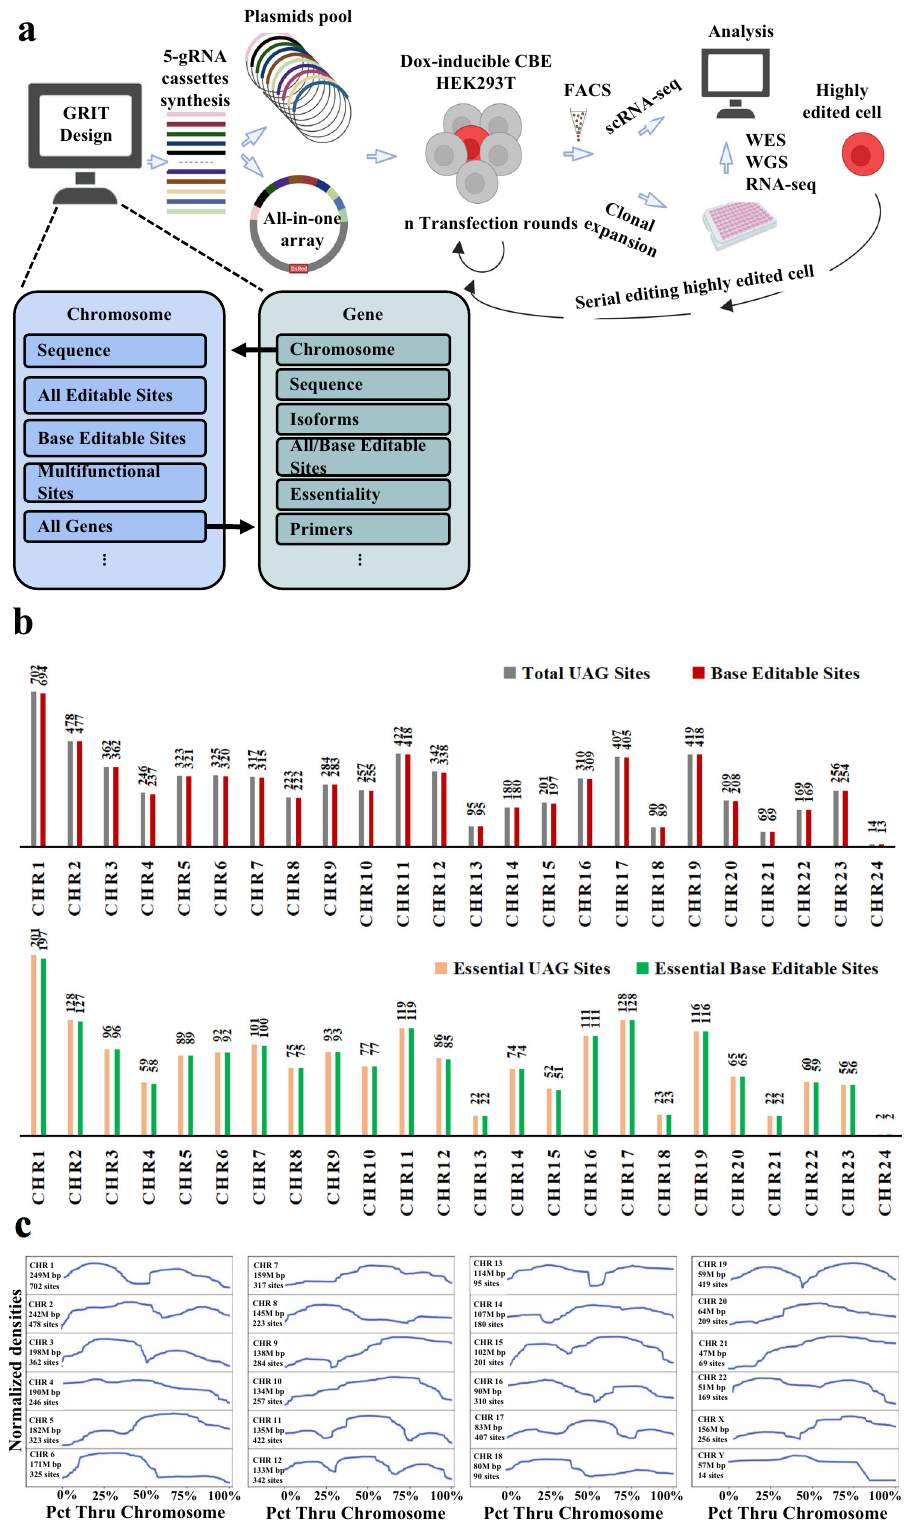
Fig. 1 Software GRIT and framework for converting UAG to UAA for human recoding. a Framework for converting TAG codons into TAA in human cells. Chromosome and gene objects structure in GRIT. Using GRIT for informatics centers around chromosome and gene objects. Each box contains some (but not all) of the attributes for each. Each chromosome contains a list of gene objects, and each gene object contains its corresponding chromosome ’ s object. n = 2 in our current experiment. CBE, cytosine base editor 23,32 . b UAG number and editable UAG sites of all genes and essential genes in each chromosome. The editable sites mean the TAGs can be converted to TAAs by cytosine base editors with editing window from position 1-13(base positions are numbered relative to the PAM-distal end of the guide RNA). c Kernel density curves for the densities of TAG codons in the GRCh38.p13 build of the human genome obtained using GRIT. The density curves for the chromosomes are normalized to have uniform height and width. Chromosome lengths and total TAG counts are given on the left-hand